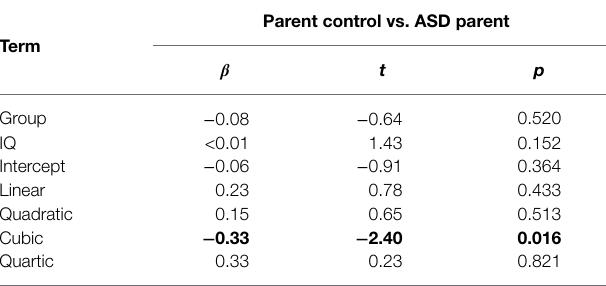
TABLE 4 | Growth curve analysis model parameters.